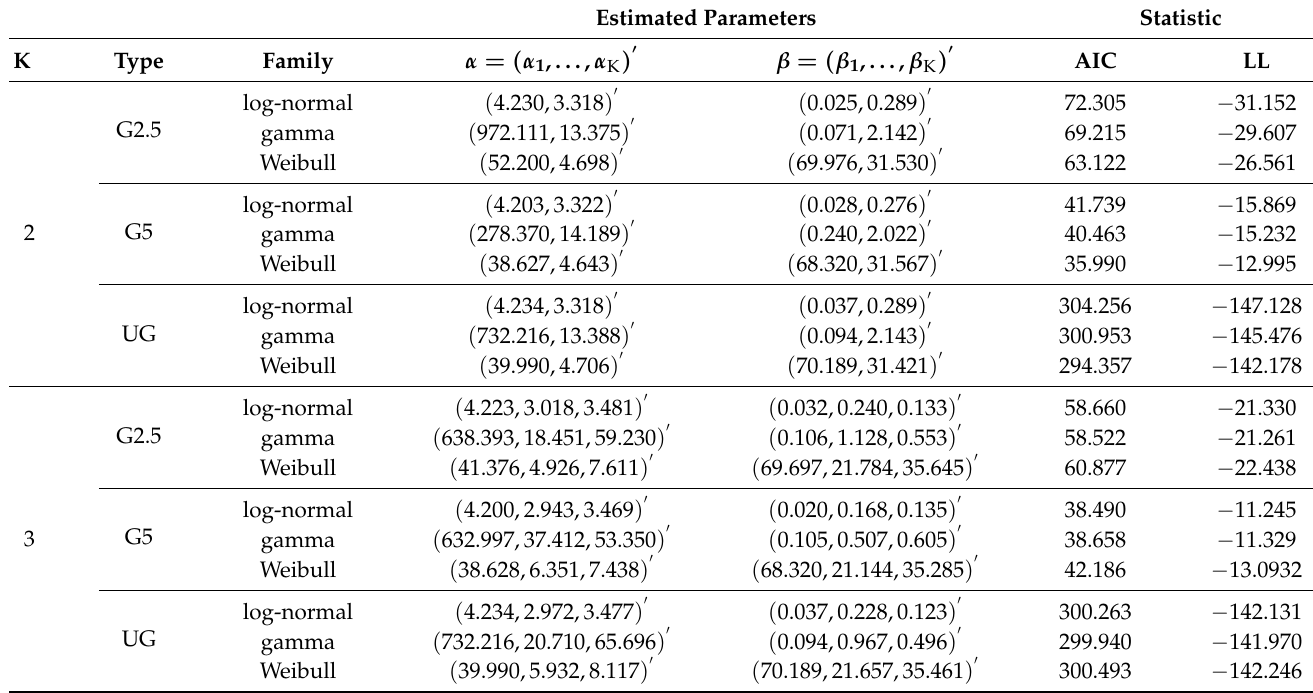
Table 2. Parameter estimates and goodness-of-fit statistics for the mixture of log-normal, gamma, and Weibull distributions fitted to sample 2 when DBH data are ungrouped (UG), grouped in classes of width 2.5 cm (G2.5), and grouped in classes of width 5 cm (G5) . It should be noted that the estimated vector of mixing parameters is not given for the sake of saving space. Estimated Parameters